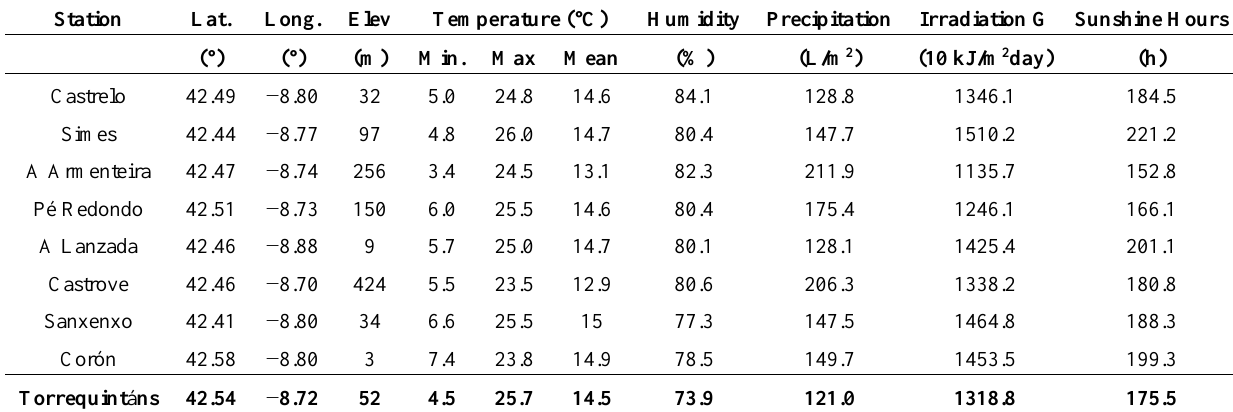
Table 2. Geographical and climatological parameters for the stations studied.